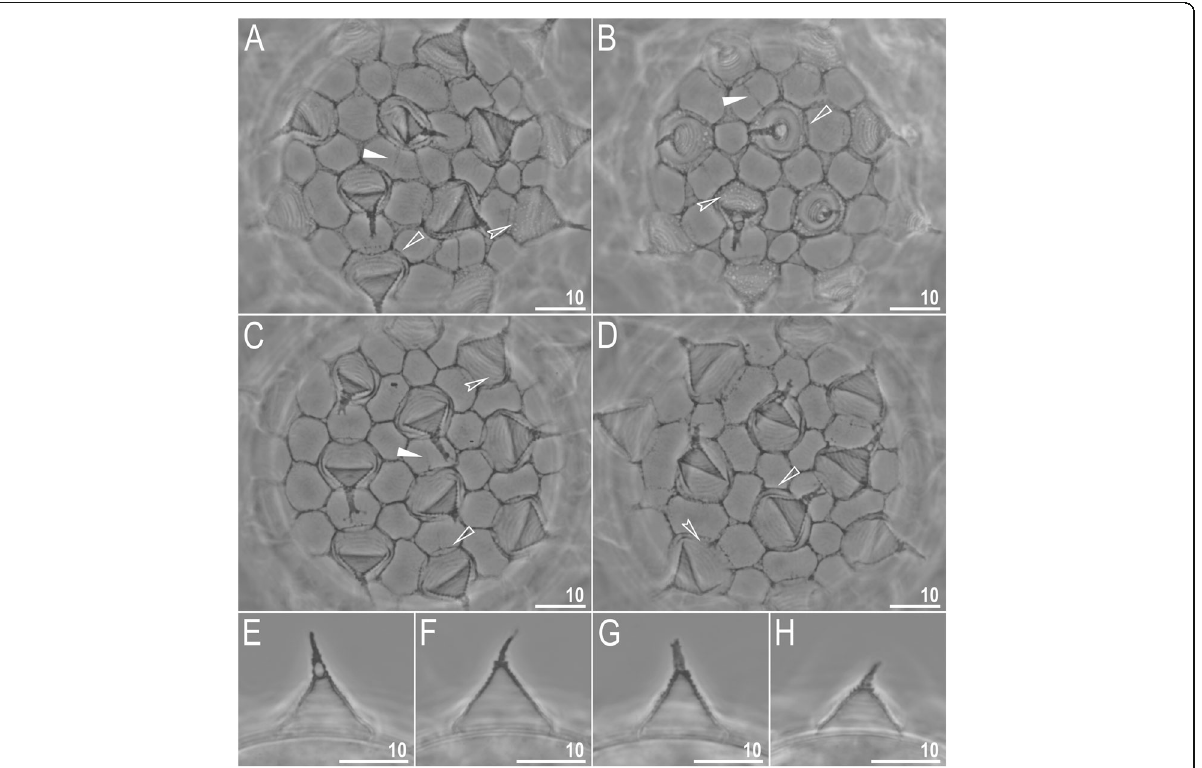
Fig. 36 Macrobiotus margoae sp. nov. from the USA (US.057) – eggs seen with LCM: a – d – surface under ×1000 magnification of four different eggs; e – h – midsections of four different egg processes. Filled flat arrowheads indicate thickenings perpendicular to the process base that divide the areola in the middle, empty indented arrowheads indicate bubbles within egg process walls, and empty flat arrowheads indicate irregular collar around process bases. Scale bars in μ